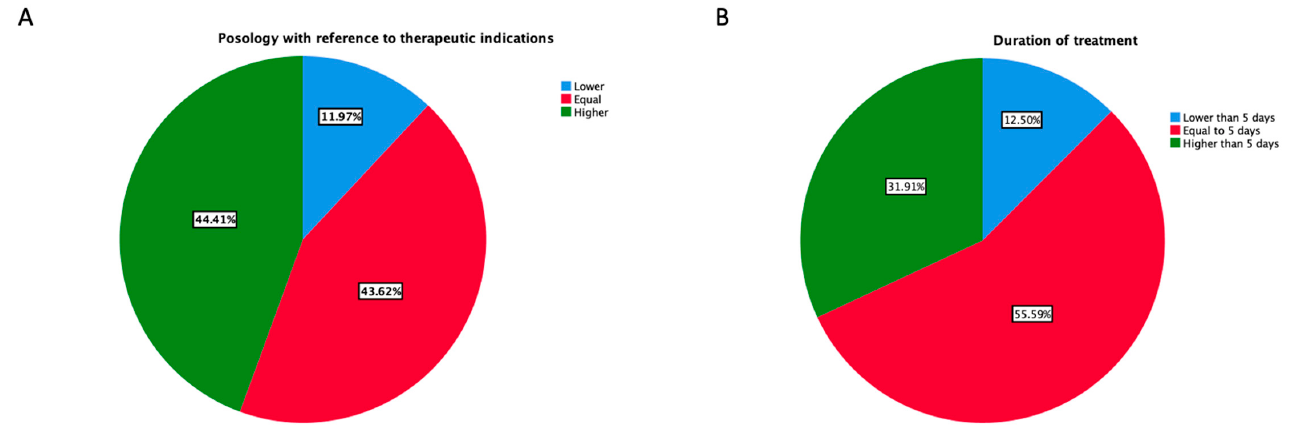
Figure 5. Intake frequency ( A ) and duration of using ( B ) of intranasal sympathomimetic amines reported by pharmacists.